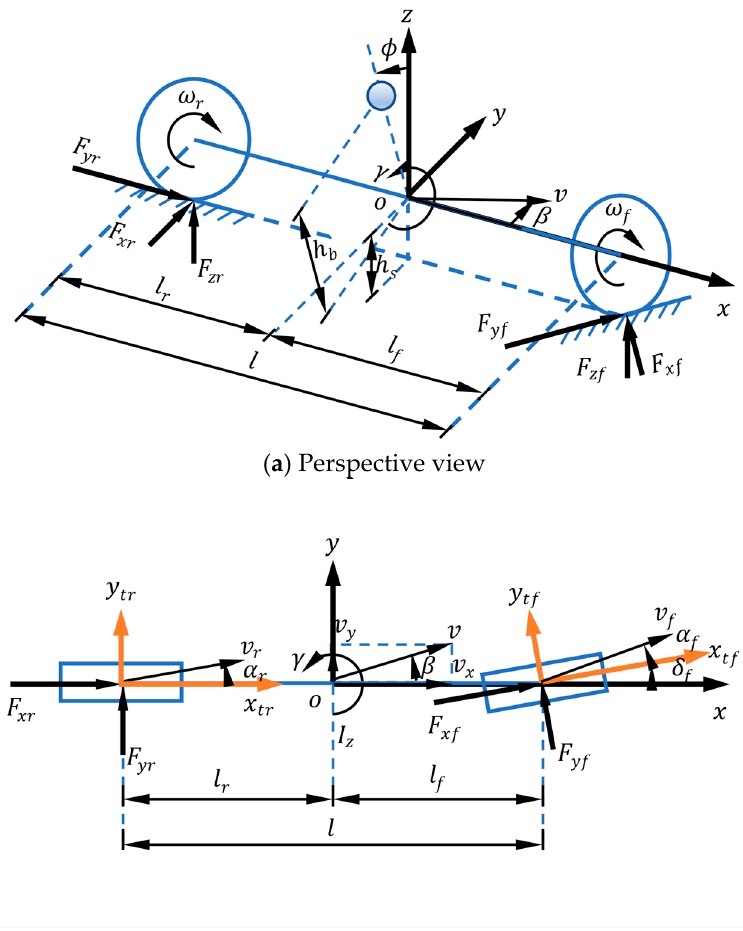
Figure 1. Vehicle dynamics model.